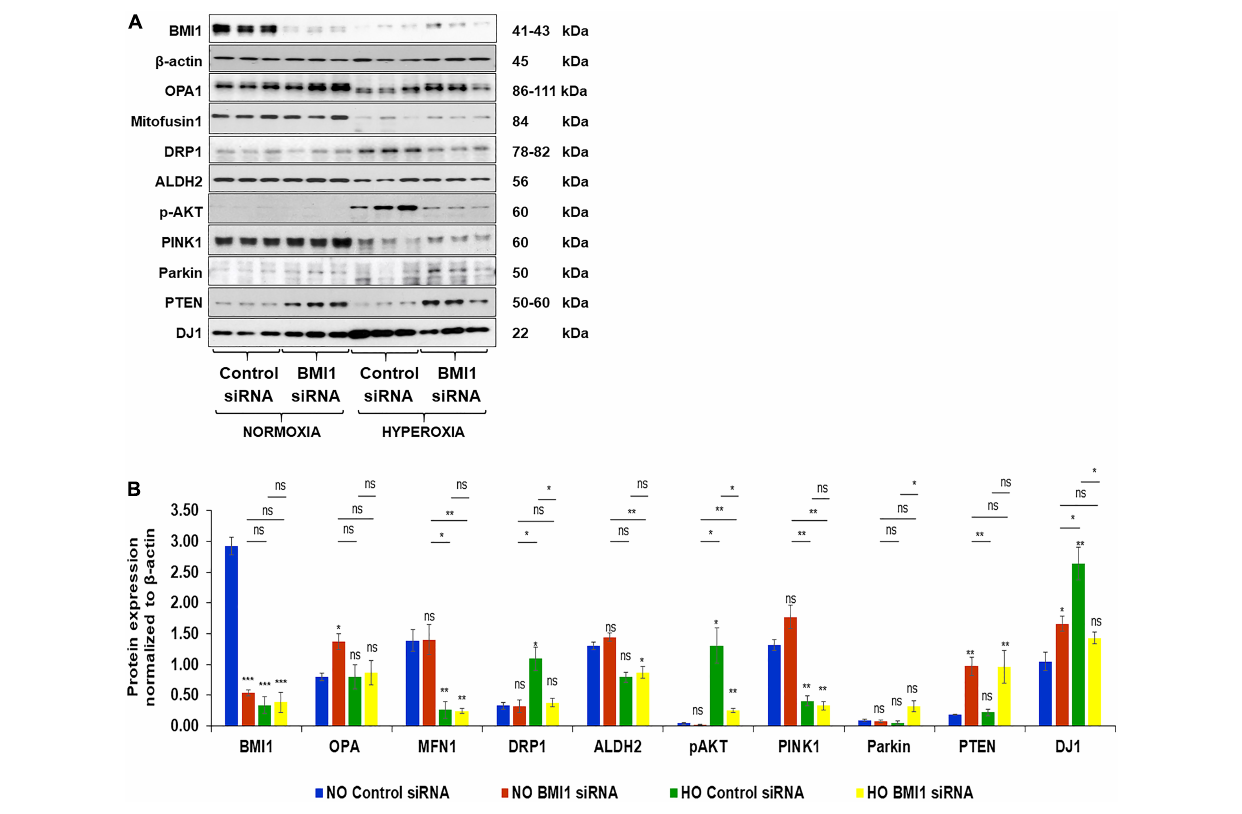
FIGURE 2 | Expression levels of proteins related to mitochondrial dynamics and metabolism in Control and BMI1 silenced H441 Cells. (A) Western blot analysis of proteins in normoxia (NO) and hyperoxia (HO). (B) Densitometric analysis of protein expression after β -actin normalization. n = 6, mean ± SEM; ns = no significant,